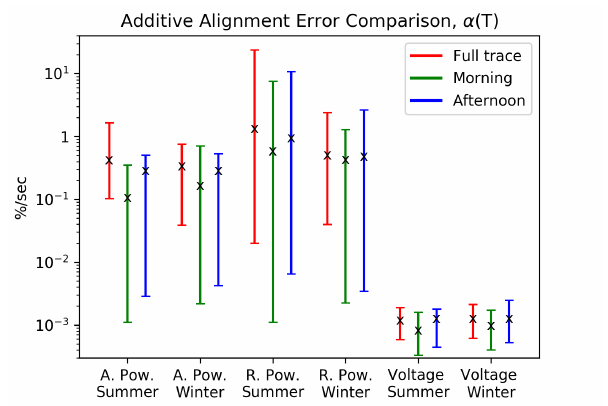
Figure 2. Additive Alignment Error α ( T ) for different electrical measurands at 30 customer con- nections obtained empirically from measurement traces for an averaging interval of T = 10 min. ’X’ marks show average over values obtained from traces in each group (30 households, Phase A); endpoints of vertical lines show maximum and minimum value of α ( T ) observed in each group; note logarithmic scale on the